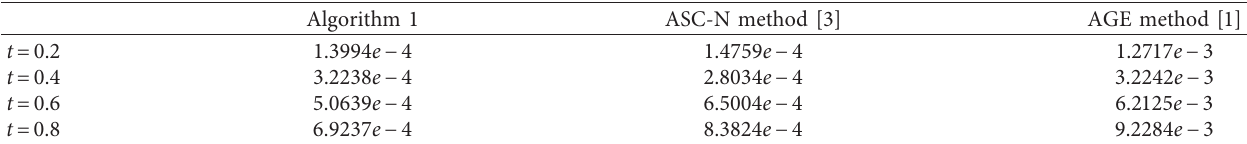
Table 6: Maximum error comparison for r � 15 and h � 1/121 (i.e., K � 20).